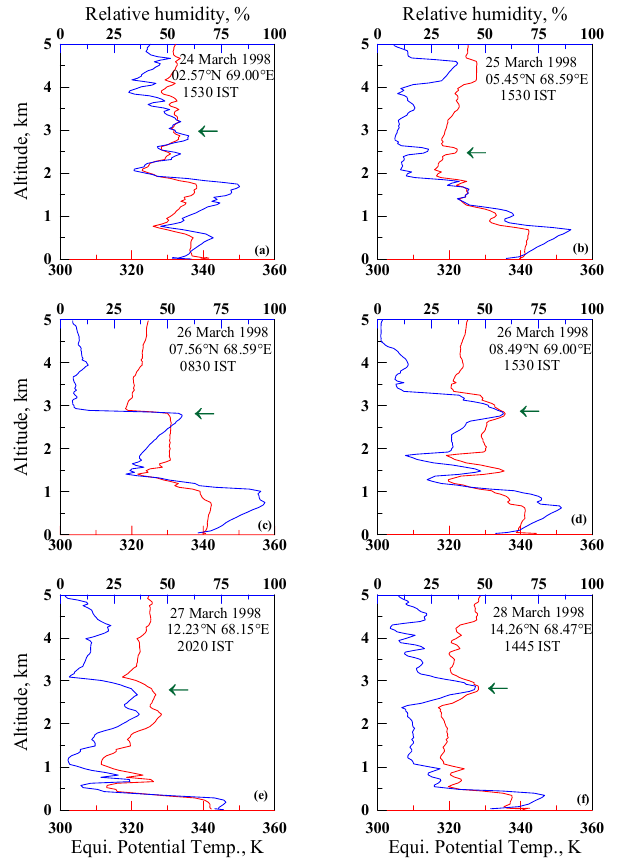
Figure 10:. Fig. 10. Altitude profiles of equivalent potential temperature ( θ e ) and relative humidity ( RH ) showing the progressive development of a layer with 2.5km with